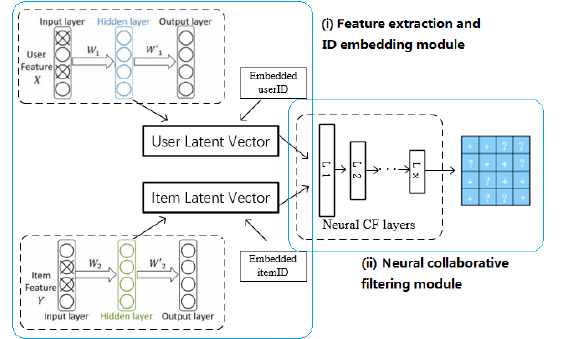
Fig. 1 Deep hybrid recommender system based on auto- encoders